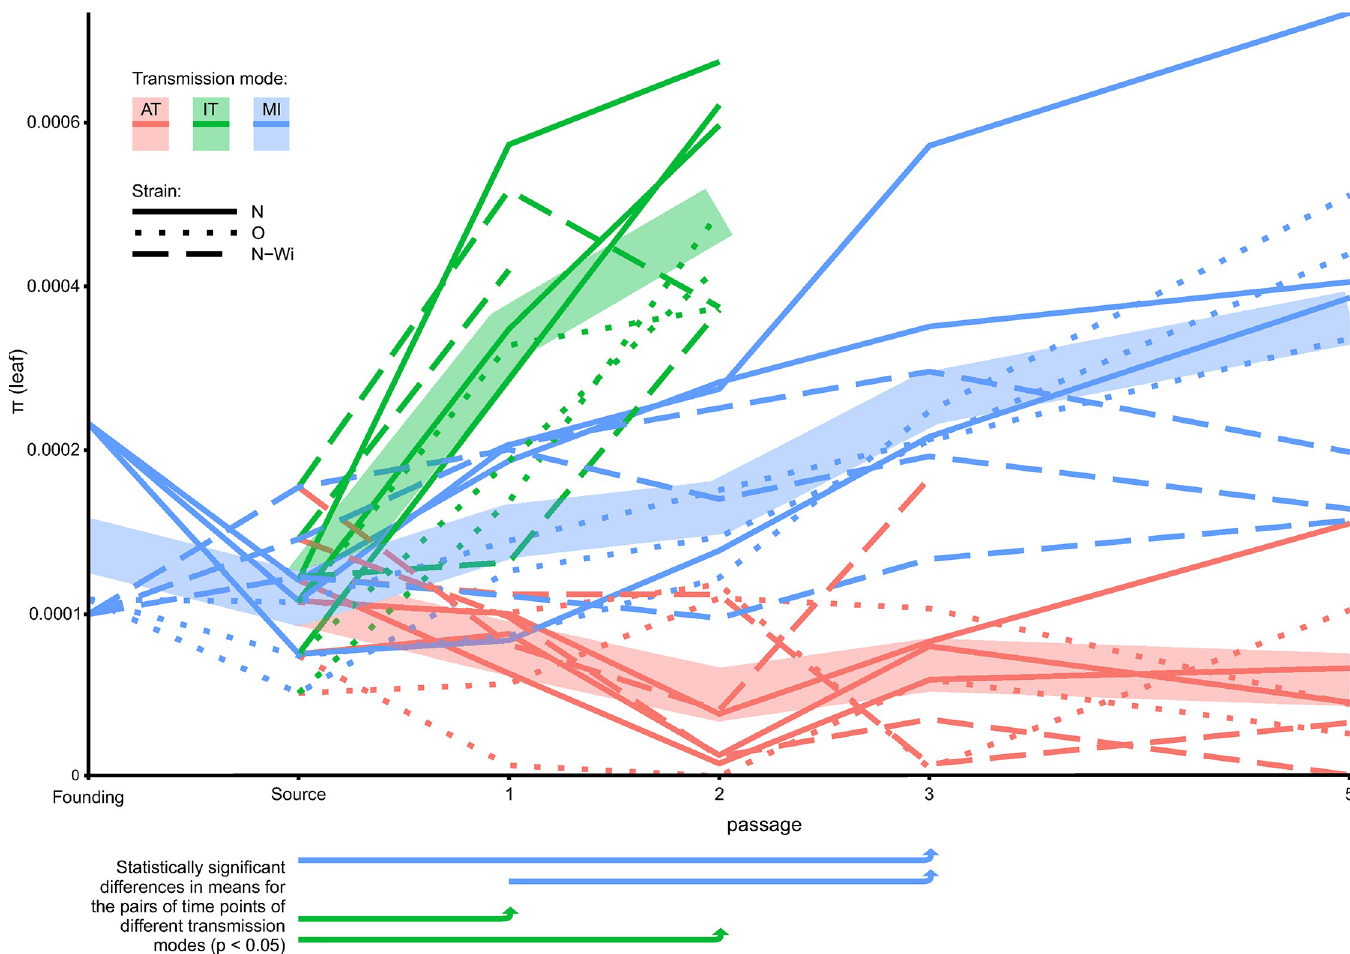
Fig 2. Temporal changes in PVY nucleotide diversities in leaves during experimental evolution using three different transmission modes. Thin lines connect PVY nucleotide diversities ( π ) in leaves for separate lineages over the course of the experiment. Colors represent the three different transmission modes (AT–aphid transmission, IT–transmission through infected tubers and MI–mechanical transmission). Line types represent the three different PVY strains used in the experiment. Thick translucent lines connect average values for all of the lineages within the same transmission mode over the course of the experiment. Below the plot, the arrows connect time points with significant increase in nucleotide diversity for specific transmission modes (based on Bonferroni-corrected post hoc pairwise comparisons of the estimated marginal means). Only the data obtained by the analysis of leaf samples is presented in this figure.